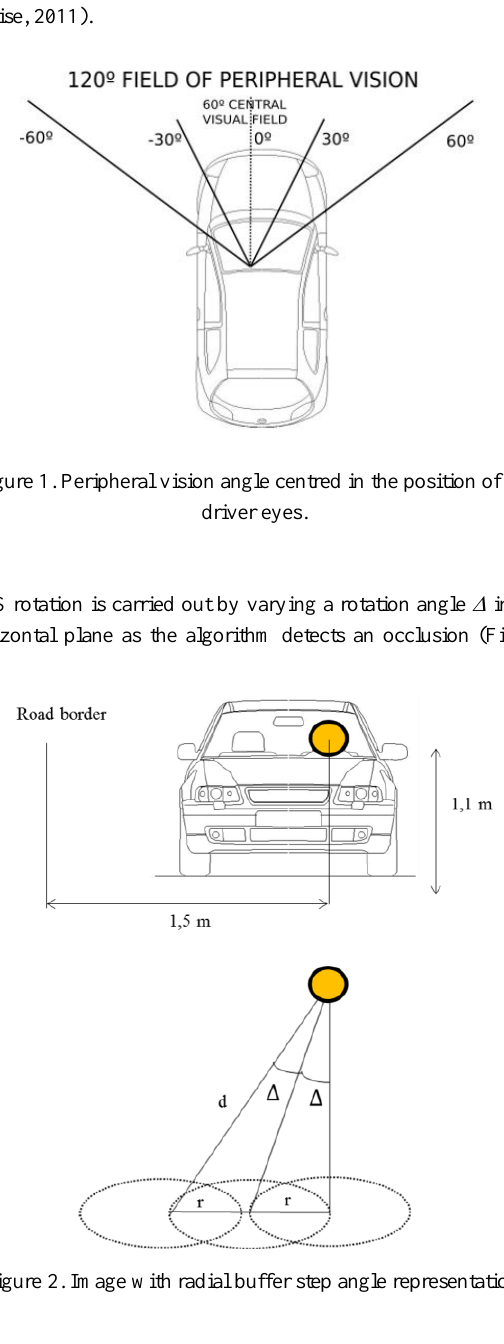
Figure 2. Image with radial buffer step angle